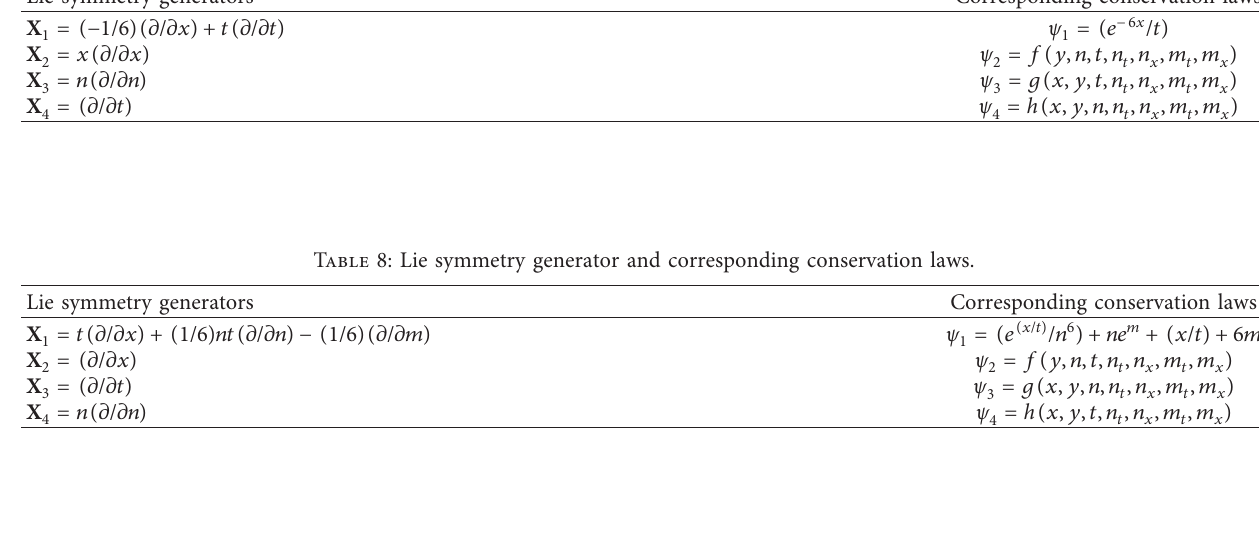
Table 9: Lie symmetry generators and corresponding conservation laws.